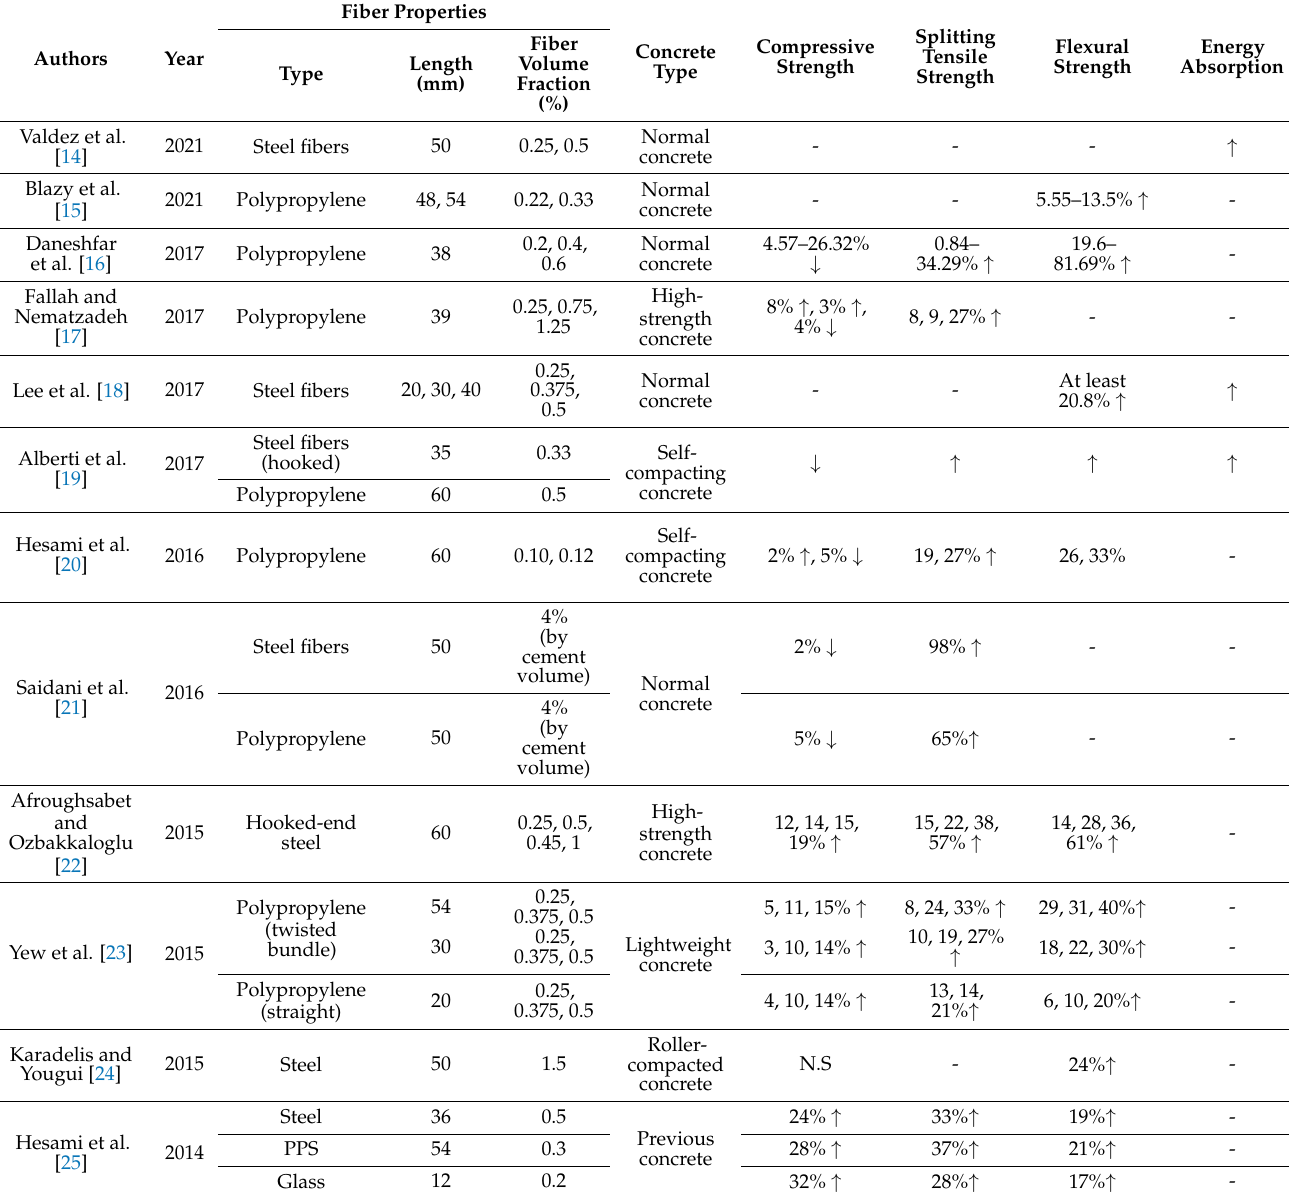
Table 1. A summary of fibers’ effects on mechanical properties, as reported in the literature (increase ↑ , decrease ↓ , not significant,